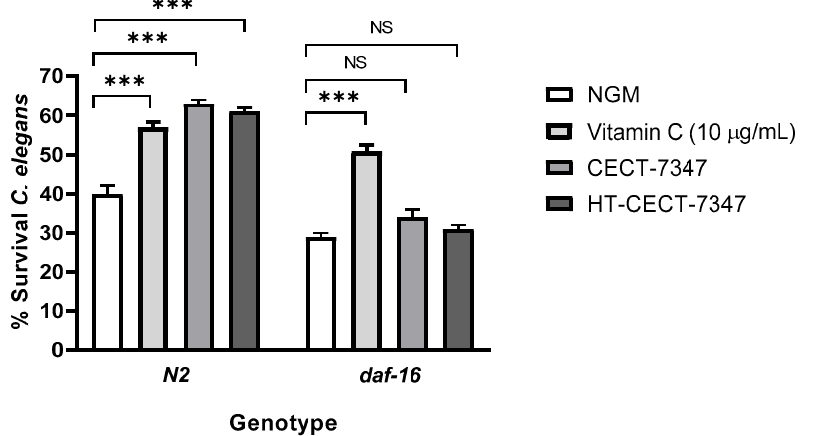
Figure 2. Survival of C. elegans mutant strain in DAF-16 fed with B. longum CECT-7347 or HT-CECT- 7347 after acute oxidative stress. NGM: Nematode growth medium used as control feeding condition. *** Significant p < 0.001; NS: No significant differences. One-way ANOVA was applied. Data are the average of two independent experiments ( n = 200/condition).